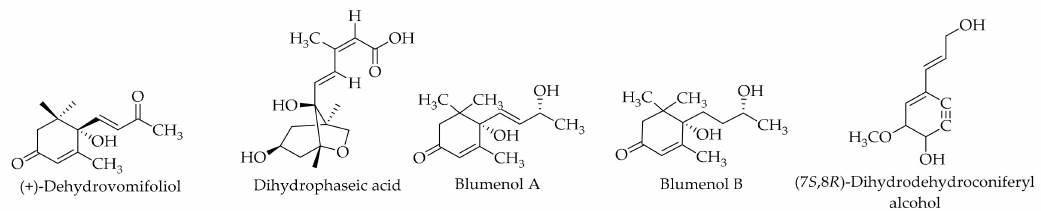
Figure 14. The chemical structures of di ff erent identified, isolated, and quantified sesquiterpenes and neolignans in the green husk of walnut.